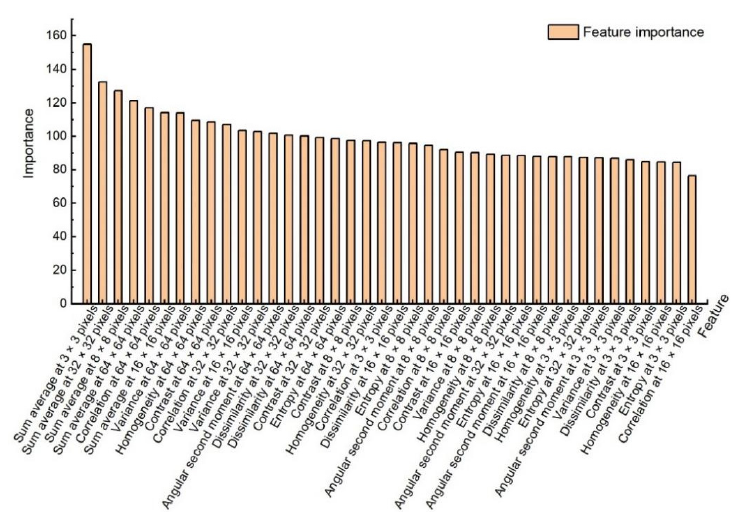
Figure A1. Importance of the features of the eight considered GLCM-based metrics under the different window sizes: 3 × 3 (90 × 90 m), 8 × 8 (240 × 240 m), 16 × 16 (480 × 480 m), 32 × 32 (960 × 960 m), and 64 × 64 (1920 × 1920 m).